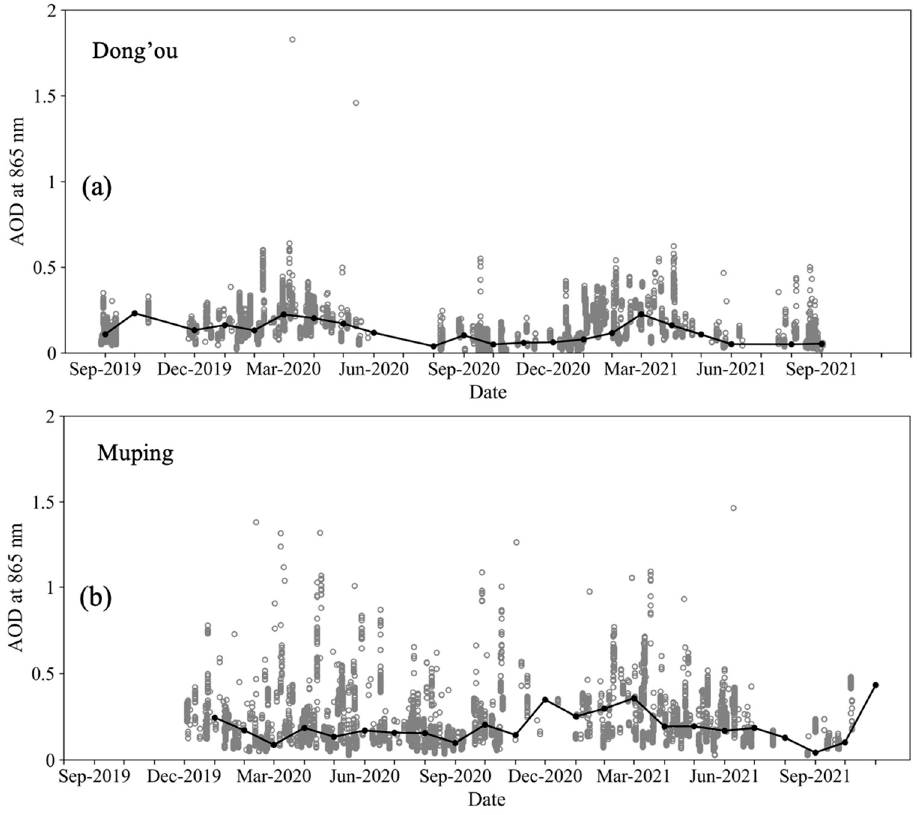
Figure 9. SeaPRISM-measured time-series aerosol optical depth (AOD) at 865 nm at the ( a ) Dong’ou and ( b ) Muping sites. The grey dots represent all valid AOD measurements and the black dots are the monthly mean values.